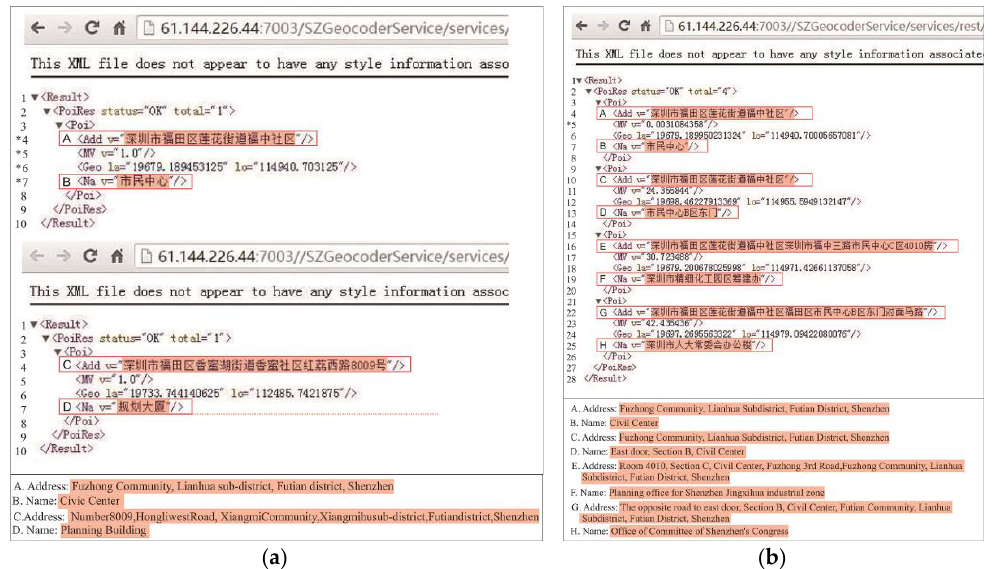
Figure 9. The online geocoding service: ( a ) address matching and ( b )reverse address matching. Note: